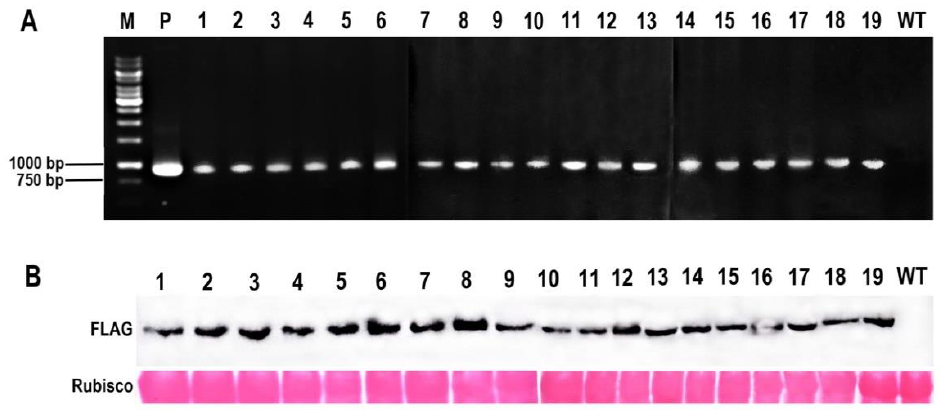
Figure 2. Identification of McHB7 -overexpressing (OE) transgenic Arabidopsis. ( A ) DNA gel image showing identification of McHB7 transcripts by PCR. M, 2000 DNA marker. P, positive control, recombinant plasmid. Nos. 1 – 19, transgenic Arabidopsis lines. WT, wild type Arabidopsis as negative control. ( B ) Western blot image of the Mc HB7 protein in the 19 Arabidopsis OE lines.